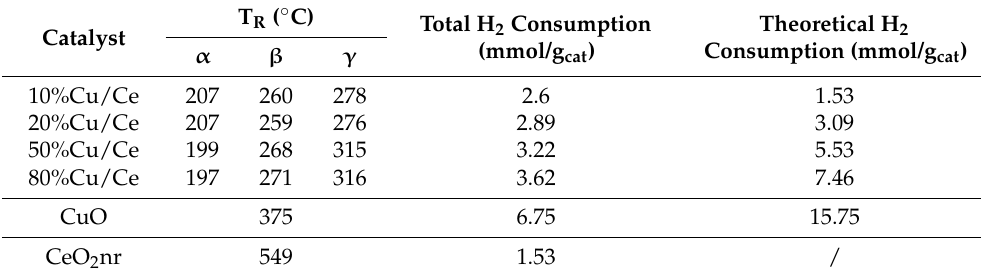
Table 2. H 2 consumption amounts of as ‐ prepared catalyst calculated by H 2 − TPR. O 2 -TPD tests were performed on the CuO/CeO 2 catalysts, CeO 2 , and CuO to investigate the desorption behavior of oxygen (Figure 6b and Table 3). Two types of oxygen exist in the catalyst, namely surface-adsorbed oxygen and lattice oxygen [39]. The peak at 180 ◦ C is related to chemisorbed oxygen around the oxygen vacancies, and the peak at 640 ◦ C is related to oxygen escaping from the lattice. As shown in Table 3, with an increase in the Cu/Ce ratio, the amount of oxygen adsorbed at low temperatures decreased, and the lattice oxygen at high temperatures